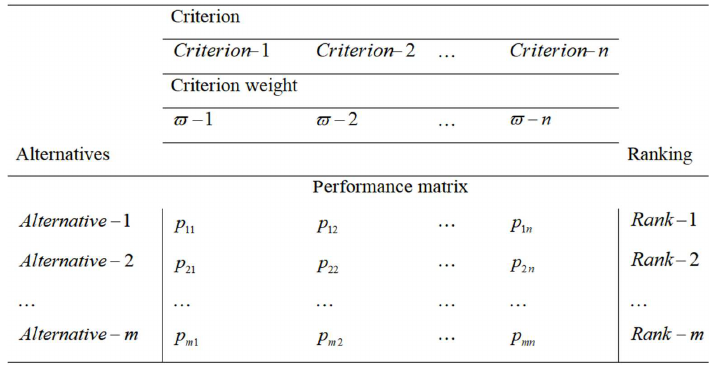
Figure 4. Architecture of the hybrid AHP-MOORA approach.